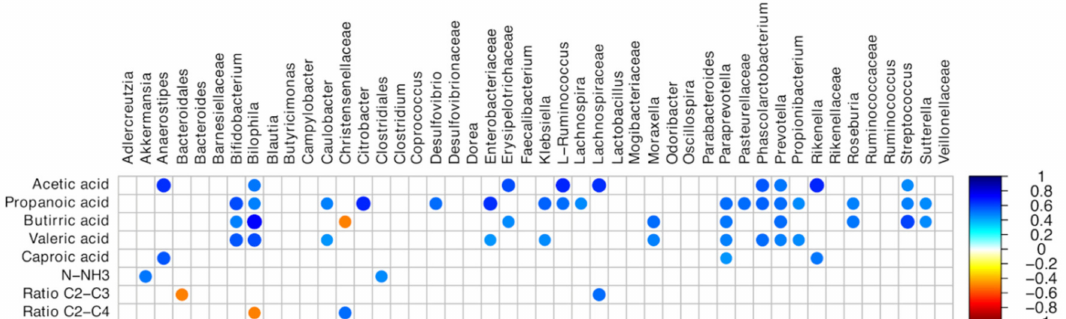
Figure 6. Spearman’s rank correlation matrix of cecal operational taxonomic unit (OTU) abundance and the volatile fatty acid profile. The colors of the scale bar denote the nature of the correlation, with 1 indicating a positive correlation (blue) and -1 indicating a negative correlation (dark red), between the two datasets; N–NH3: ammonia-N; C2: Acetic acid; C3: Propanoic acid; C4: Butyric